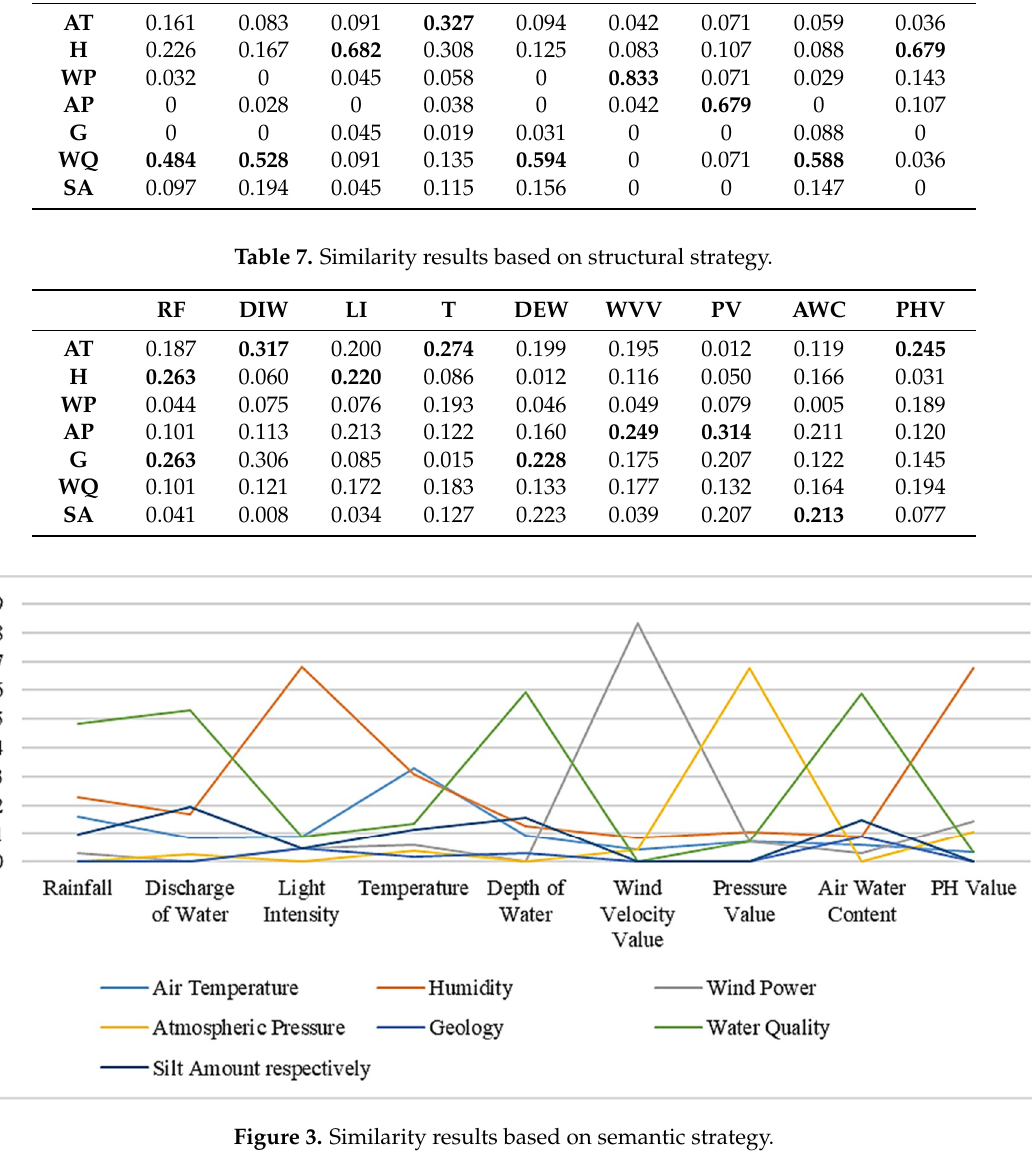
Figure 4. Similarity results based on structural strategy. Different from other synthetic methods of similarity computation, we use the analytic hierarchy process (AHP) and three different strategies to screen similarity. In this experiment, first we eliminate concept pairs below the threshold by using a semantic-based similarity strategy. Assuming a threshold of 0.03, concept pairs like geology-rainfall, atmospheric pressure-rainfall, wind power- discharge of water, geology-discharge of water can be eliminated. Then we set the threshold to 0.04 and further filter based on structural strategy. Finally, by setting the threshold to 0.2, we can use the instance-based similarity strategy to get the result of the concept match. As shown in Figure 5 and Table 8. This method, on the one hand, eliminates the need for domain experts to adjust the weight of the comprehensive calculation. On the other hand, it reduces the calculation consumption of some unnecessary concepts.